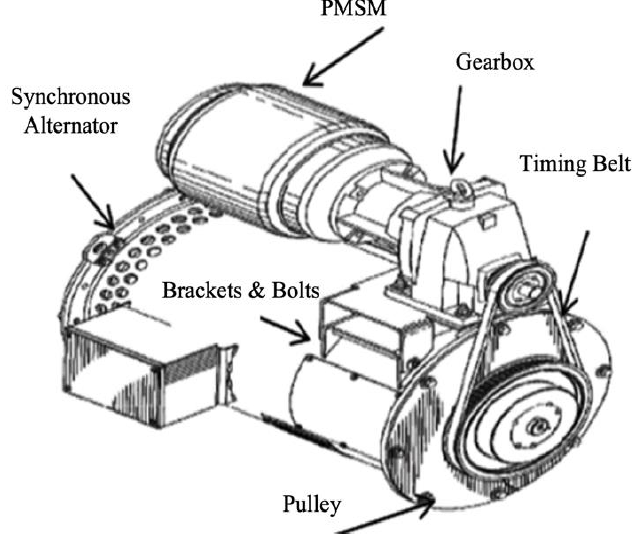
Figure 12. PMSG configuration using non-static stator [82].